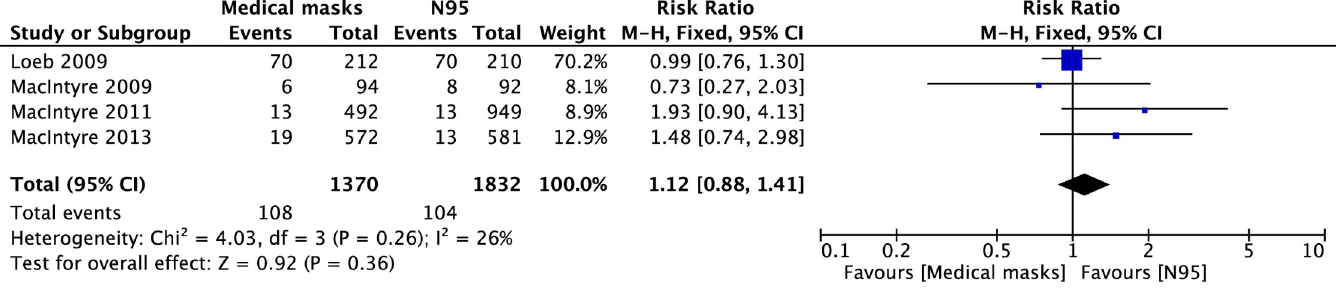
Fig 3. Forest plot of laboratory-confirmed infection with any respiratory viruses in medical masks vs. N95 groups. The center of each square represents the relative risk for individual trials, and the corresponding horizontal line stands for 95% confidence interval. The diamonds represent pooled results.